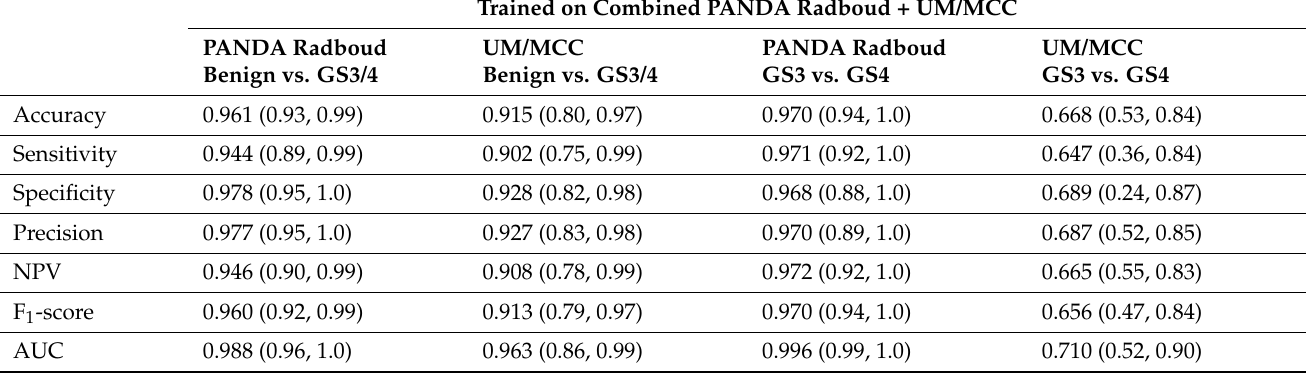
Table 5. PANDA + UMMCC